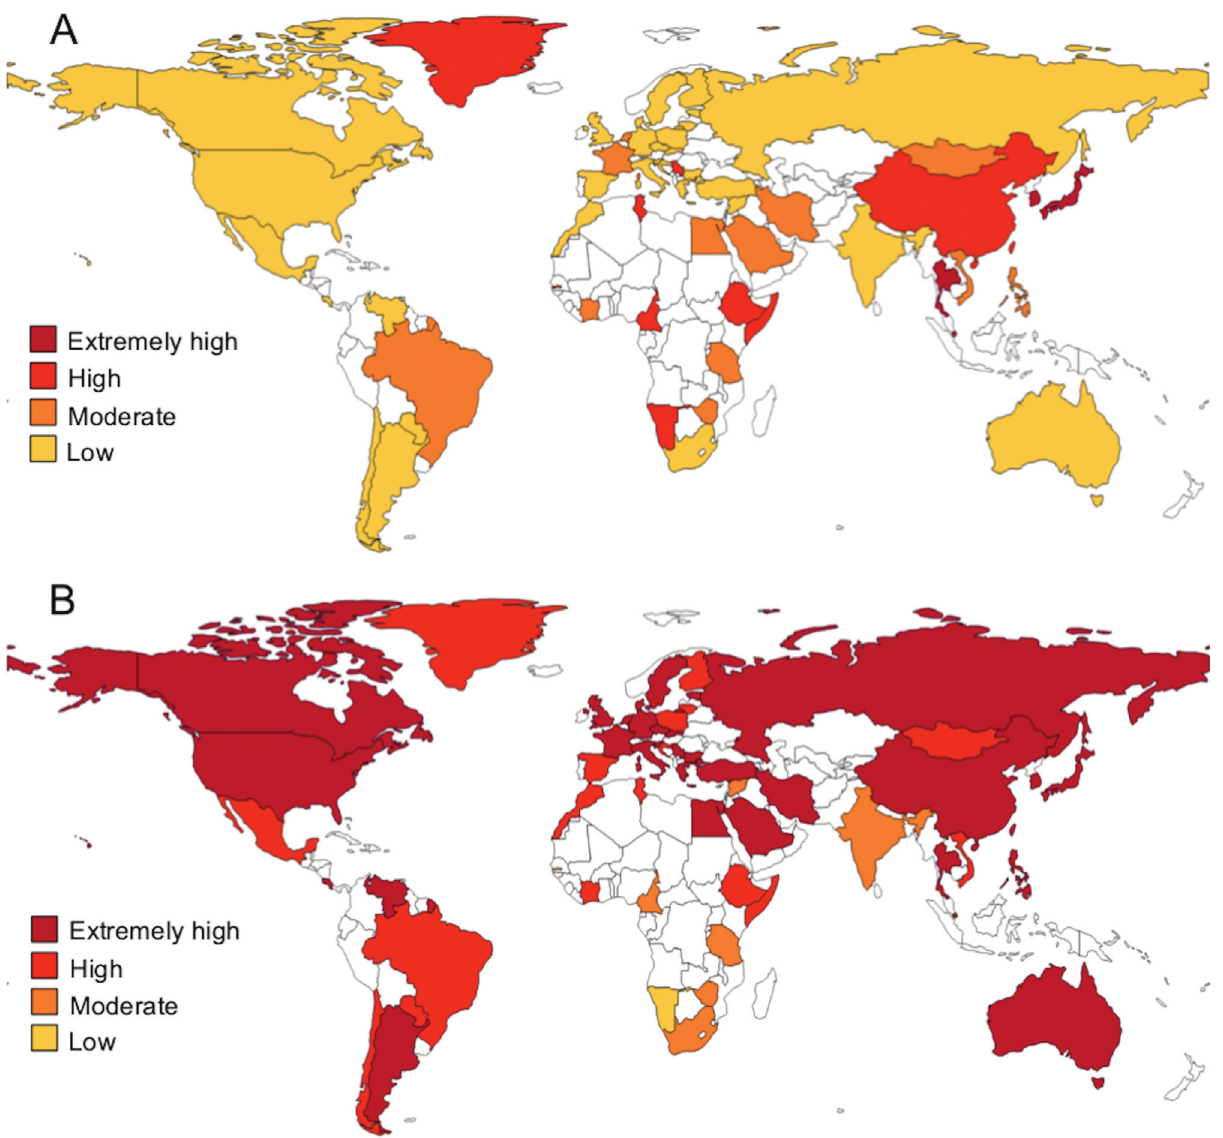
Figure 3 - Distribution of GSTT1 (A) and GSTM1 (B) null genotypes in 57 countries. Low: 0.10–0.22; moderate: 0.23–0.35; high: 0.36–0.48; extremely high: